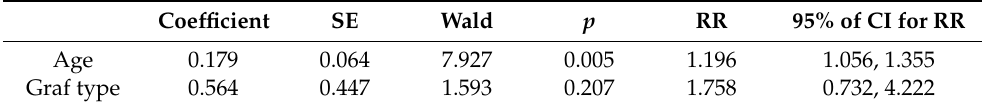
Table 3. Logistic regression analysis to evaluate risk factors for